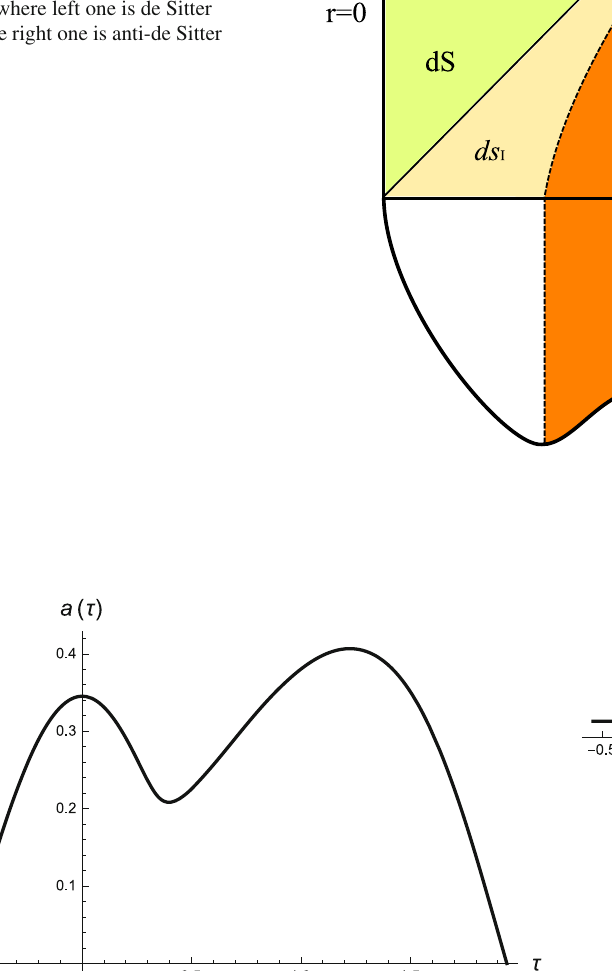
Fig. 4 The analytic continuation to Lorentzian signatures. Here, r is the areal radius. The triangular part is the region where the metric ds I is applied. In the orange colored part, the spacetime includes a time-like wormhole. The green colored parts satisfy the metric ds II , where left one is de Sitter and the right one is anti-de Sitter